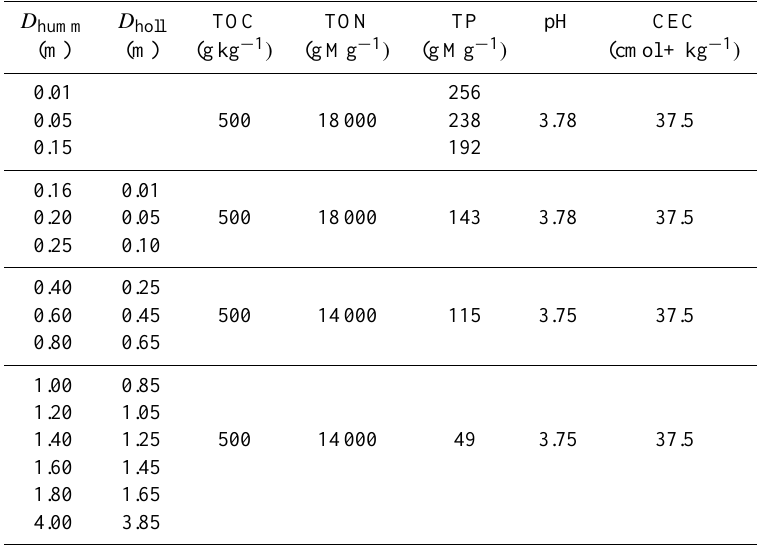
Table 1. Key soil properties as ecosys inputs to represent a drainage affected tropical peat swamp forest at Palangkaraya, Indonesia ∗ . D humm D holl TOC TON TP pH CEC (m) (m) (gkg − 1 ) (gMg − 1 ) (gMg − 1 ) (cmol+ kg − 1 ) 0.01 256 0.05 500